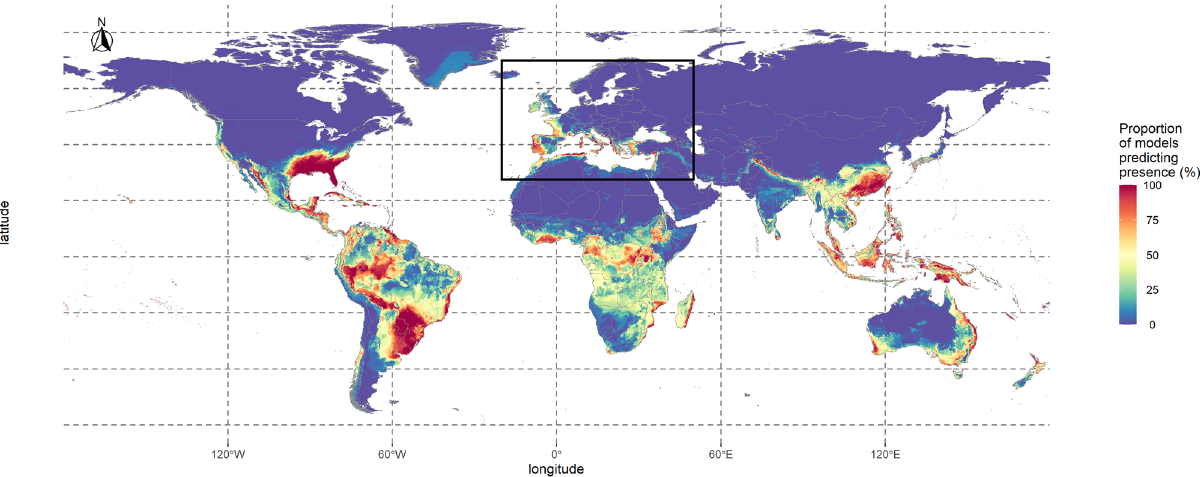
Figure 2. Consensus map showing habitat suitability for Xylosandrus compactus under current climate conditions. This consensus map was computed by averaging binary maps and represents the percentage of models predicting each pixel as suitable. The black square represents the limits of the focal area. The map was generated using R 4.0.0 (https ://cran.r-proje